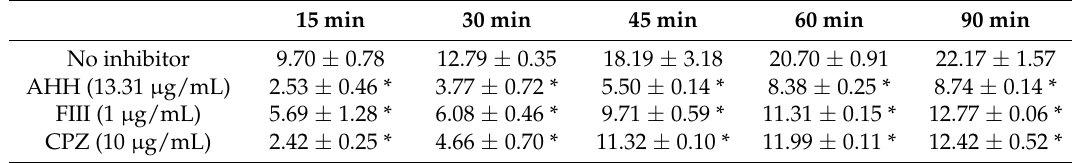
Figure 6. LPPC encapsulation enhanced cell uptake of BP through induction of endocytosis. ( A and B ) The cells were incubated with BP (50 µg/mL) or BP/LPPC (50 µg/mL) for 0, 15, 30, 45, and 60 min, and then extracted for BP value analysis using a fluorescence spectrophotometer. The fluorescence of BP was blue. * p < 0.05 versus BP group. Table 3. The inhibition effect of BP/LPPC cell uptake by endocytosis inhibitor.